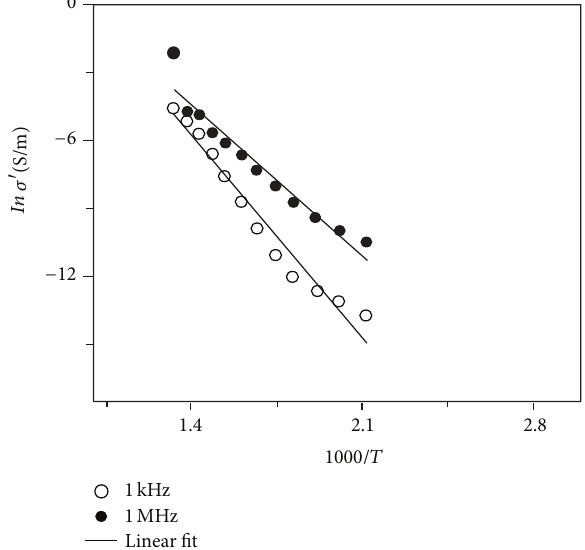
Figure 8: Variation of real part of ac conductivity with inverse of temperature at 1KHz and 1MHz for PGT